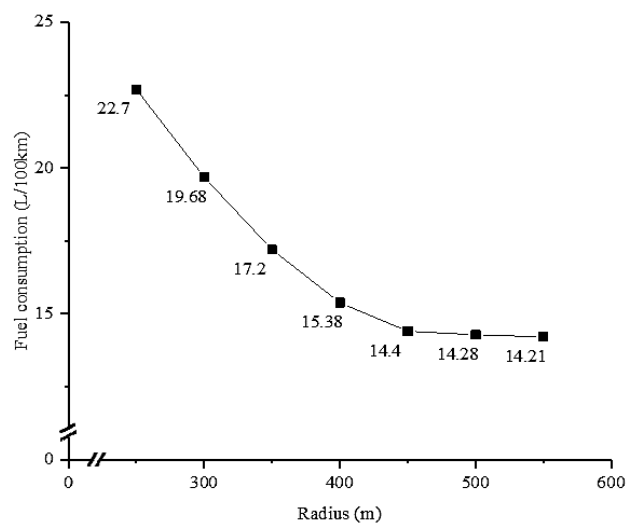
Figure 7. Fuel consumption with different radii.